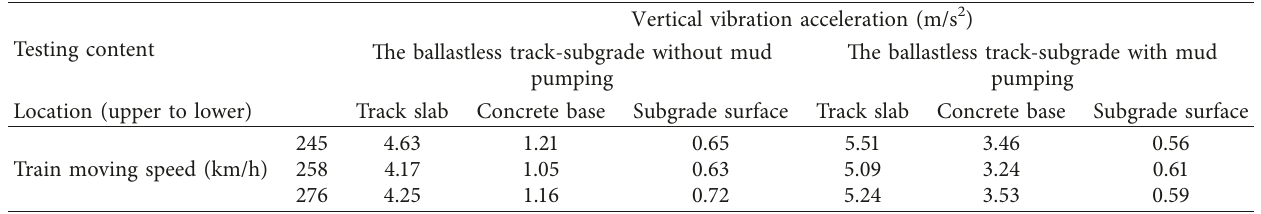
Table 3: The vertical vibration acceleration of the ballastless track-subgrade with and without mud pumping. Testing content